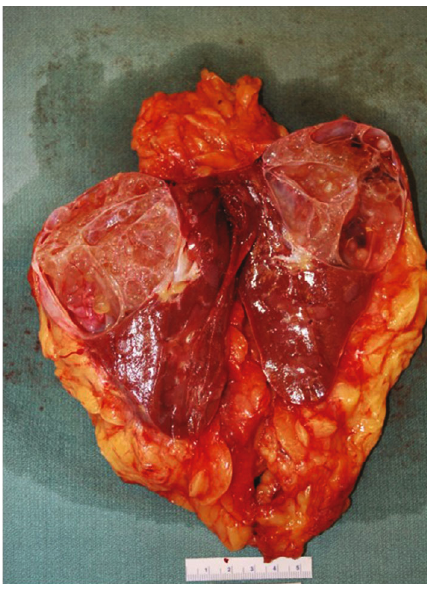
Figure 1: Gross appearance of the tumor. A well-circumscribed solid and cystic neoplasm is present at upper pole of the kidney and shows cysts of variable sizes on cut surface. The cysts were fi lled with clear watery fl